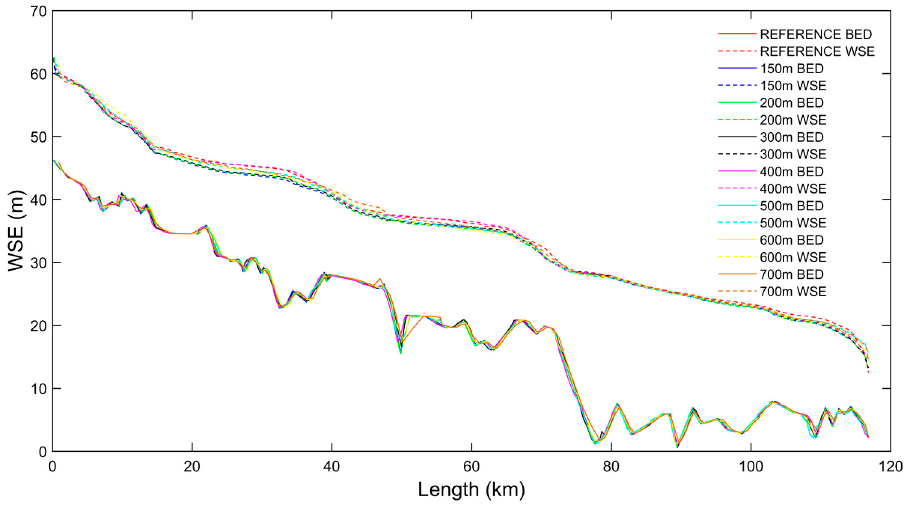
Figure 5. River channel flow profile with simulated maximum water surface level at 150 m and coarser resolutions.